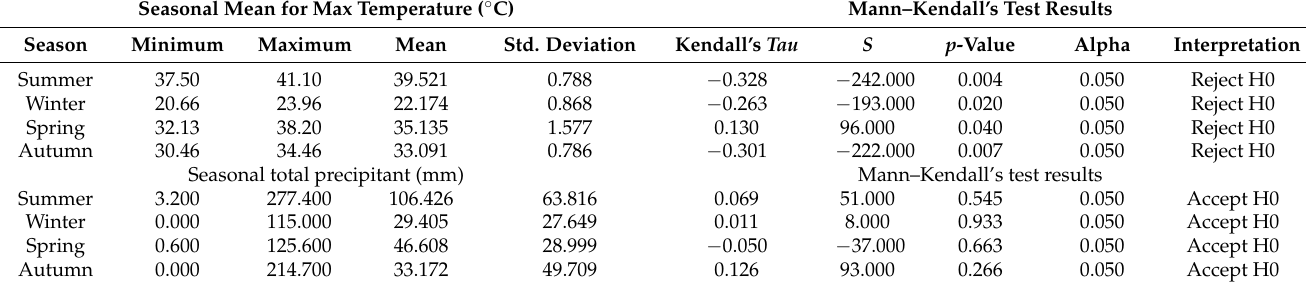
Figure 7. Climograph along with Mann–Kendall’s test results showing trends for monthly average temperature and monthly total precipitation. Table 2. Summary statistics for seasonal temperature and precipitation along with Mann–Kendall’s test